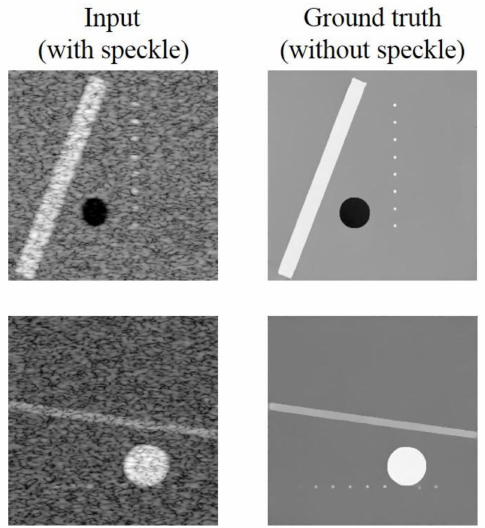
Figure 1. Flowchart of simulated ultrasound B-mode image.